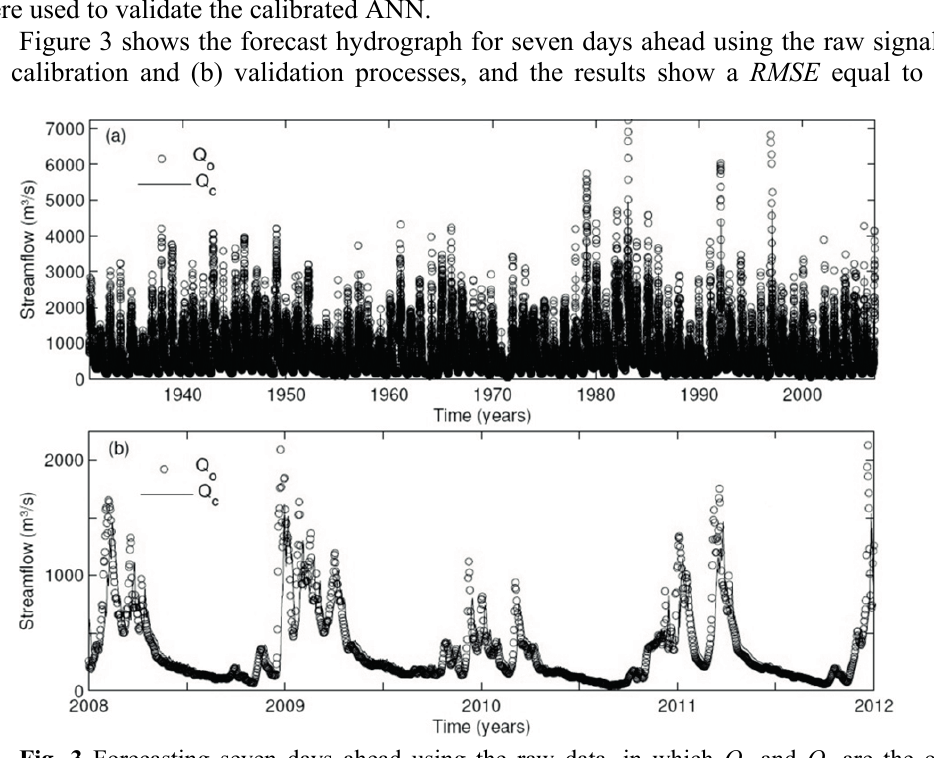
Fig. 3 Forecasting seven days ahead using the raw data, in which Q o and Q c are the observed and calculated inflows (Regular ANN model),